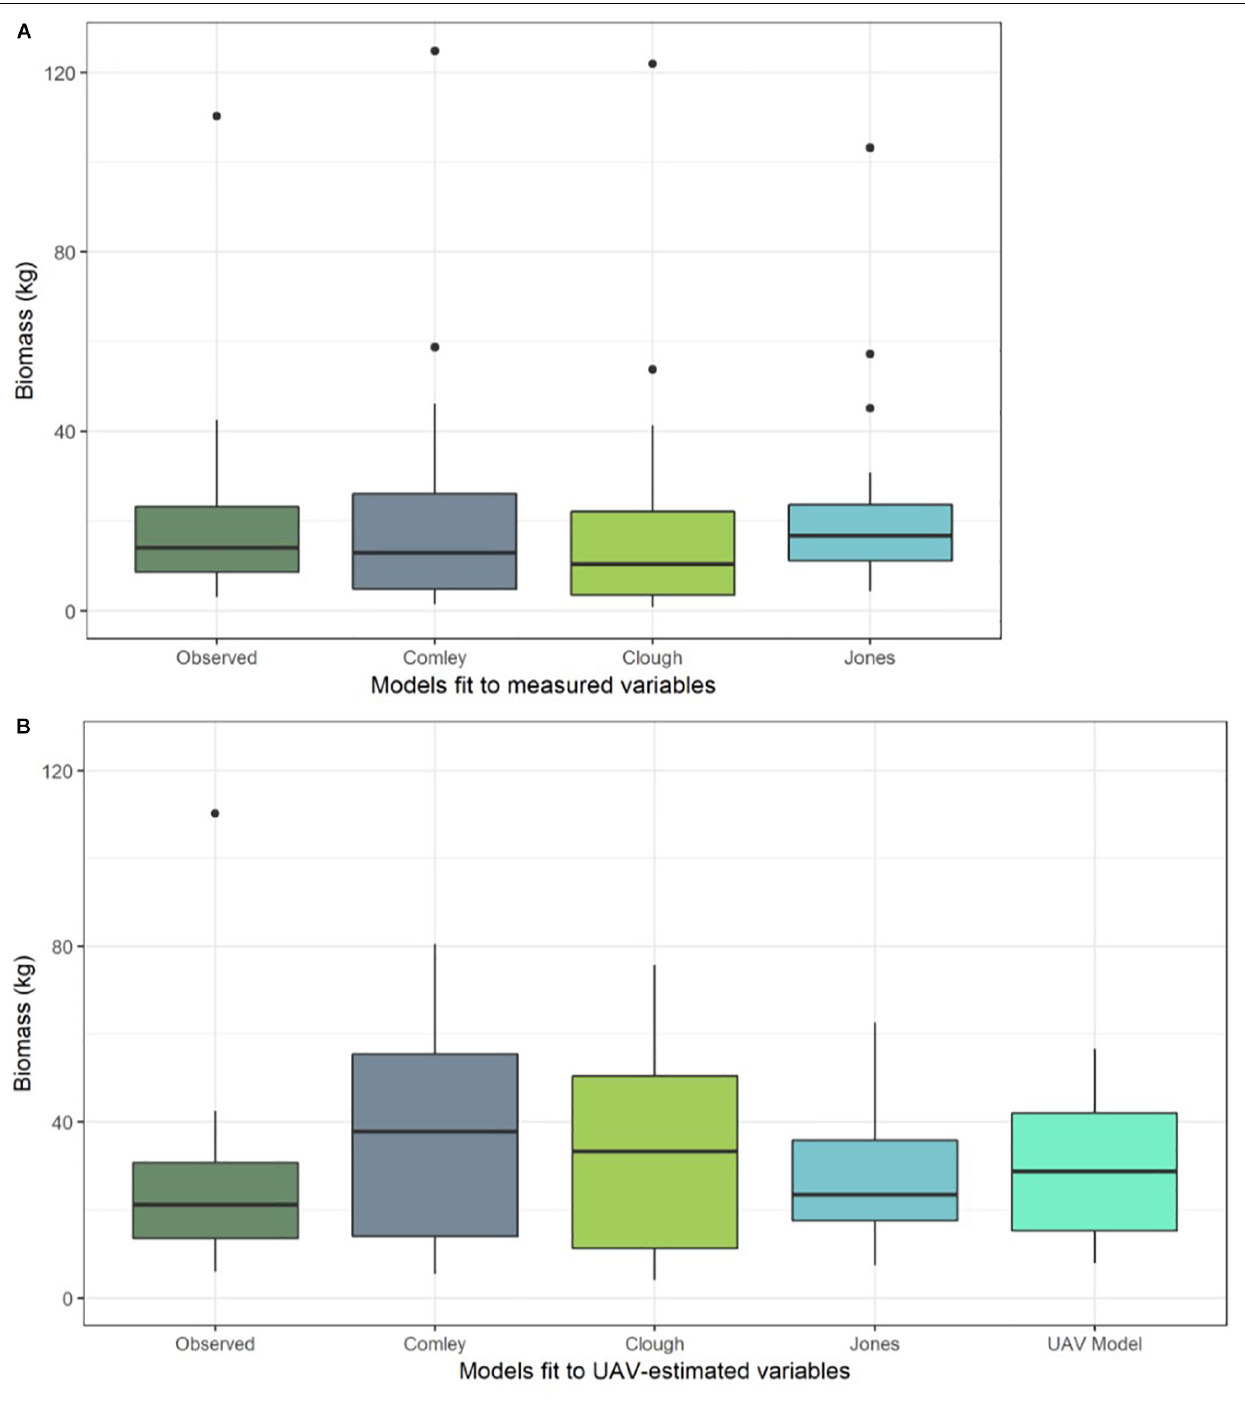
FIGURE 5 | Boxplots of predicted biomass (kg) from a selection of the best performing allometric equations [Comley and McGuinness (2005); Owers et al. (2018a) and Jones – this study] when fit to (A) physically measured tree data from all harvested trees ( n = 20) and (B) predictions from the same equations, but using UAV image-based measurements of variables to predict biomass (rather than physically measured variables). Predictions of tree biomass from the best model that was trained directly on the UAV image-based measurement data are also shown in (B) (“UAV Model”). Horizontal dark line shows the median biomass prediction, upper and lower box extents show the first and third quartiles respectively, whiskers extend to 1.5 times the interquartile range and black points indicate